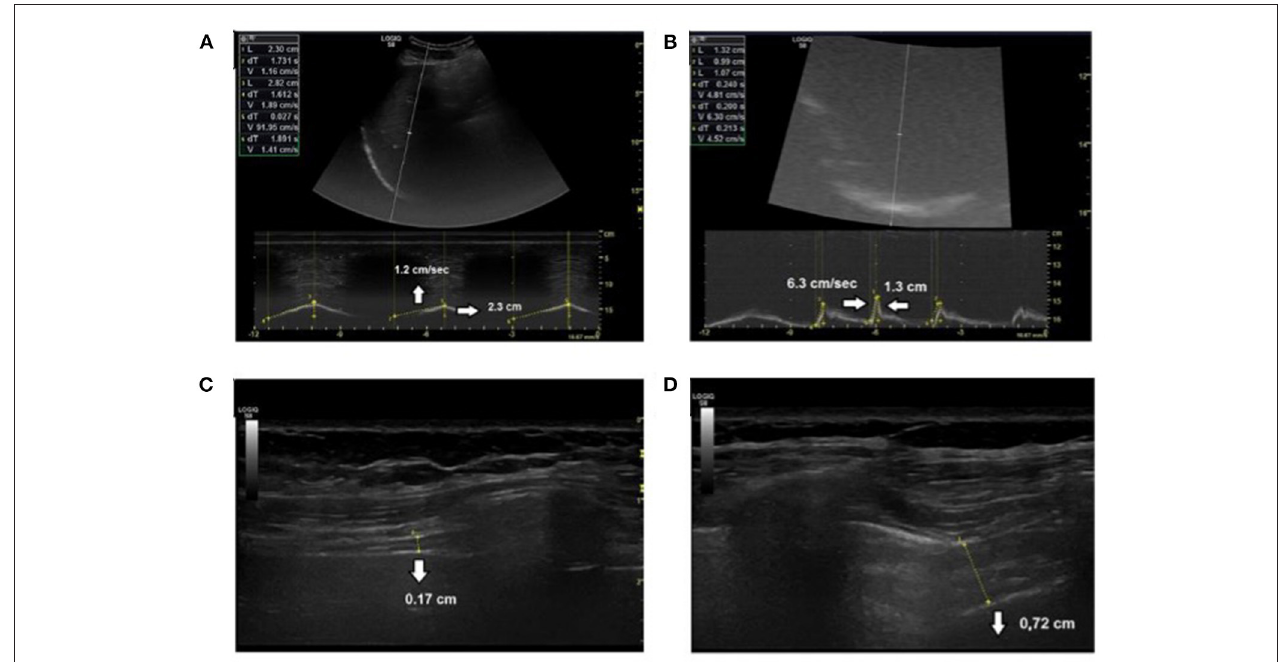
FIGURE 1 | Diaphragm ultrasound measures. (A) Diaphragm excursion amplitude and velocity during tidal breathing, (B) diaphragm excursion amplitude and velocity during voluntary sniff, (C) diaphragm thickness at functional residual capacity, and (D) at total lung capacity.